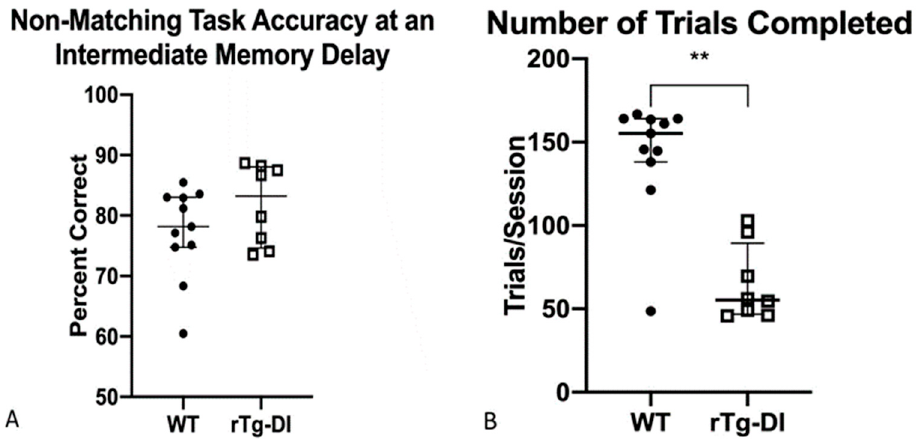
Figure 6. Accuracy and frequency of responding on a non-matching response task at a moderate 5 s memory delay added (DNMTP) at 10 months of age, WT data represented as filled circles, rTg-DI represented as boxes. rTg-DI rats responded as accurately as WT rats ( A ) but completed fewer sequences than WT rats ( B ) ** p < 0.001. Data are represented as statistical dispersion or median across number of trials to meet criteria at the 5 s delay + interquartile range.